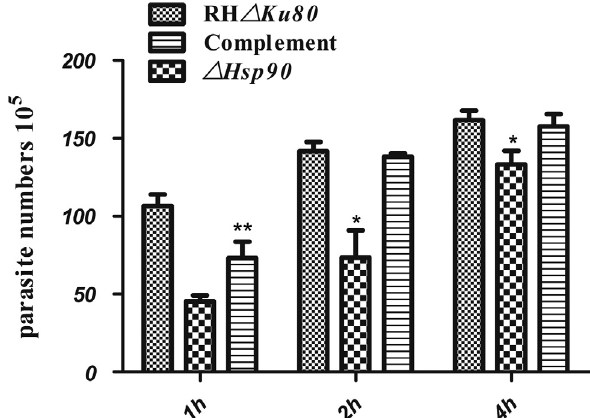
Figure 5. Invasion of the D Hsp90 parasite. The invasion ratio of D Hsp90 , RH D ku80 and complemented parasites was evaluated, the points of time were 1, 2 and 4 h, and anti-SAG3 monoclonal antibody was used as the red-green attachment assay. Fields were randomly selected and data were mean ± SD of three independent experiments. ‘‘**’’ and ‘‘*’’ indicate statistically significant differ- ence at p < 0.01 and p < 0.05, respectively.